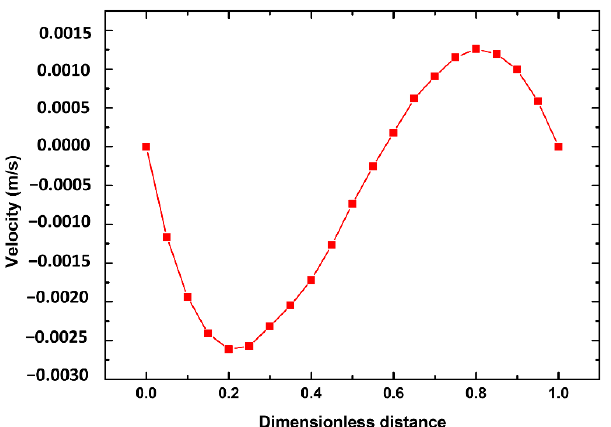
Figure 10. Longitudinal velocity distribution of the AB transversal in the middle of the closed annulus cavity.